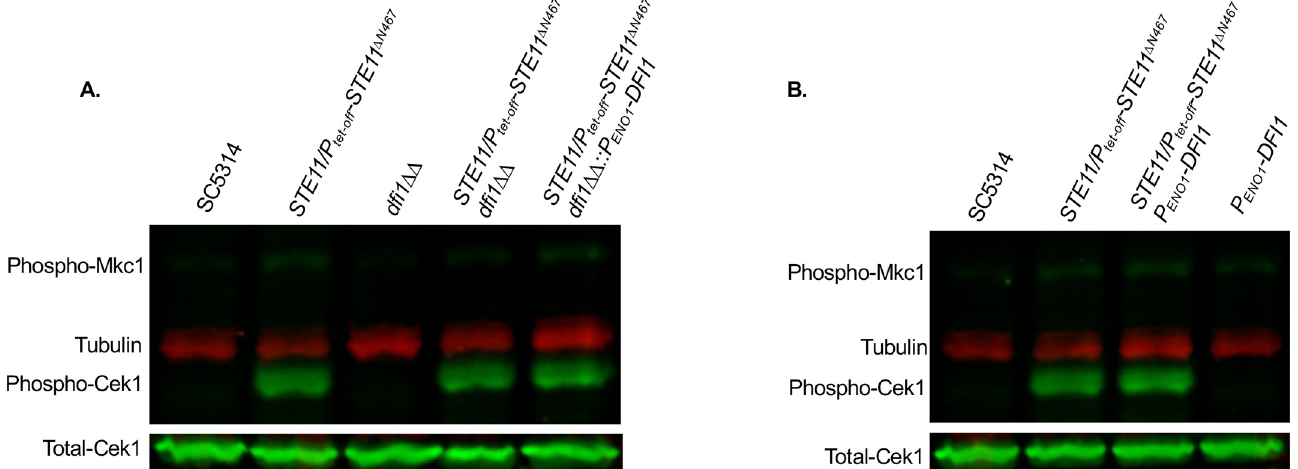
Fig 8. Dfi1 does not mediate Ste11 Δ N467 -induced activation of the MAPK Cek1. Proteins were harvested from cells grown to mid-log phase for western blot analysis. Membranes were blotted using an anti-P44/42 antibody for phosphorylated Cek1 detection and an anti-Cek1 antibody for total Cek1 detection. (A) Western blot showing active and total Cek1 levels in DFI1 deletion mutants. (B) Western blot showing active and total Cek1 levels in DFI1 overexpression mutants.